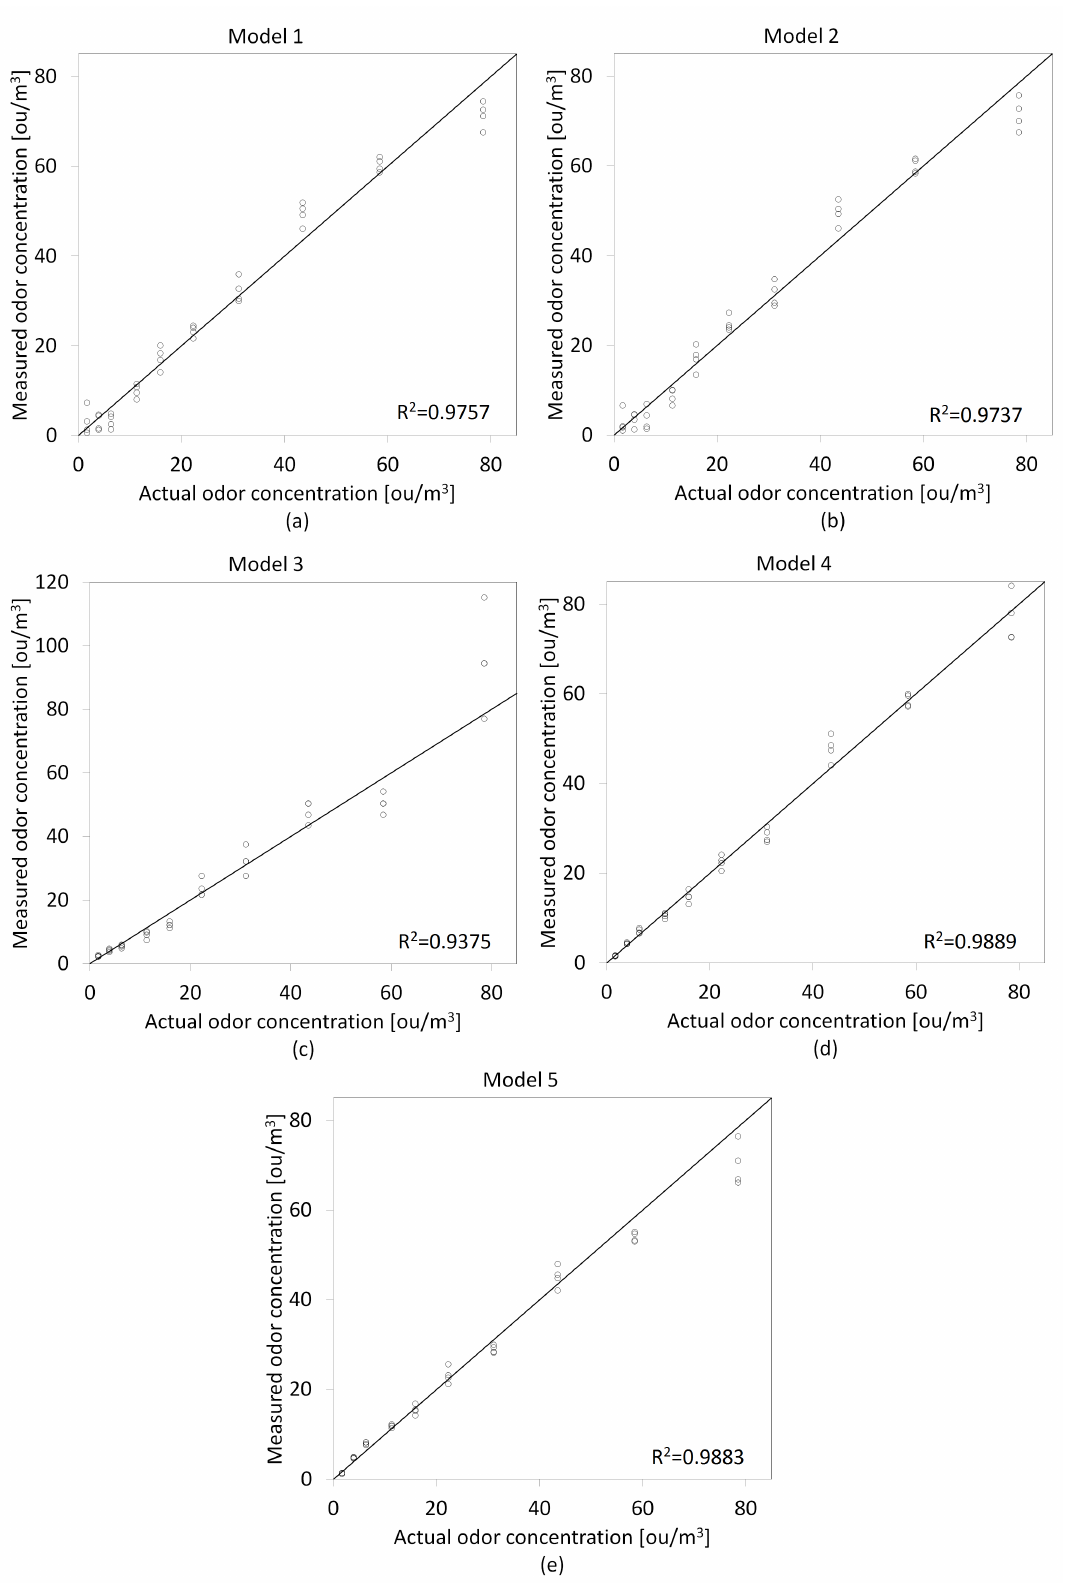
Figure 6. Comparison scatter plots of odor concentrations prediction models prepared using signal value in dB - S dB as an independent variable: ( a ) Model 1, ( b ) Model 2, ( c ) Model 3, ( d ) Model 4, ( e ) Model